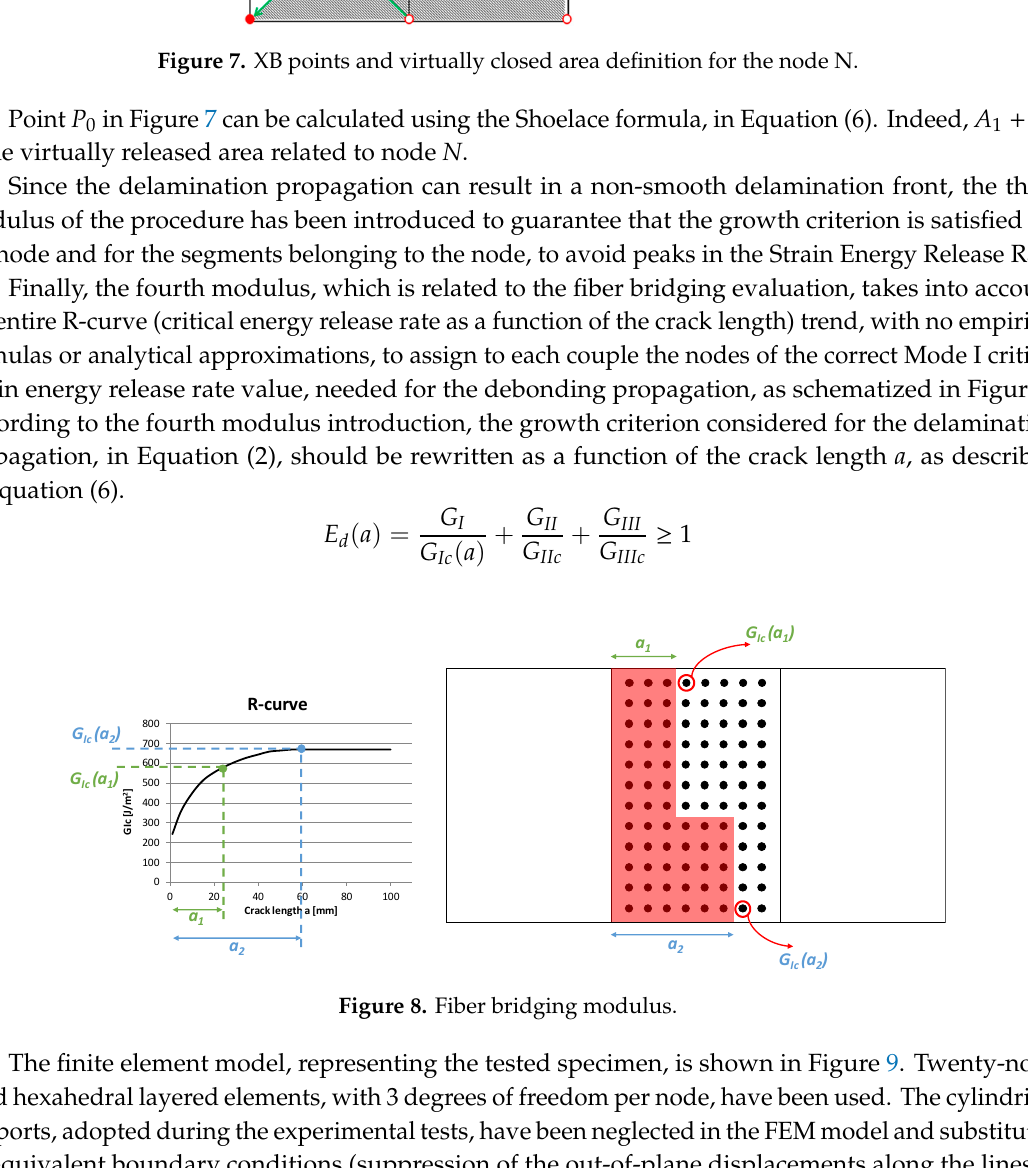
Figure 7. XB points and virtually closed area definition for the node N.